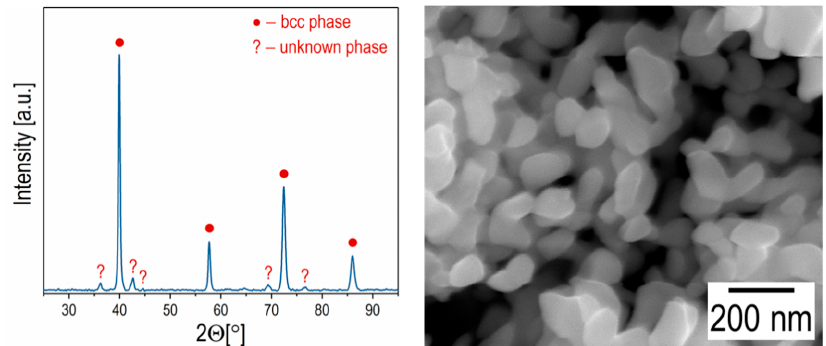
Figure 3. X-ray diffraction pattern and scanning electron micrograph of the nanoporous high-entropy TaMoNbVNi alloy.